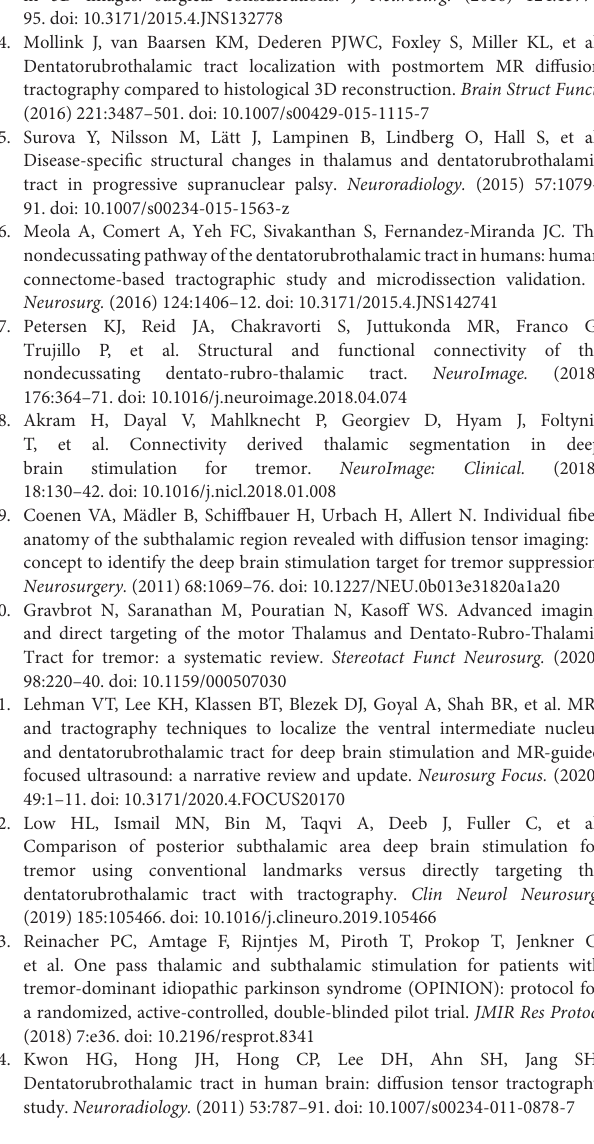
independently segmented tracts are reported in column 2. Pearson correlation coefficients between tract-averaged fractional anisotropy (FA) from the two independently segmented tracts are reported in column 3. L, Left; R, Right. Supplementary Table 2 | Principal component analysis on cerebellar tracts after Varimax rotation of the first three components. For each resulting component, the explained variance, associated eigenvalue, and the component loadings of all considered tracts are reported, as is the statistical comparison between patients (PD) and healthy controls (HC), as computed with a two-sample t- test. L, Left; R, Right. Supplementary Table 3 | Principal component analysis on cerebellar tracts after oblique rotation of the first three components. For each resulting component, the explained variance, associated eigenvalue, and the component loadings of all considered tracts are reported, as is the statistical comparison between patients (PD) and healthy controls (HC), as computed with a two-sample t -test. L, Left; R,